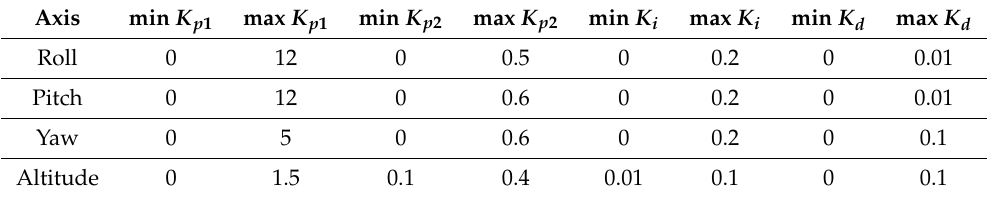
Table 1. Allowable parameter ranges of the quadrotor UAV PID controller